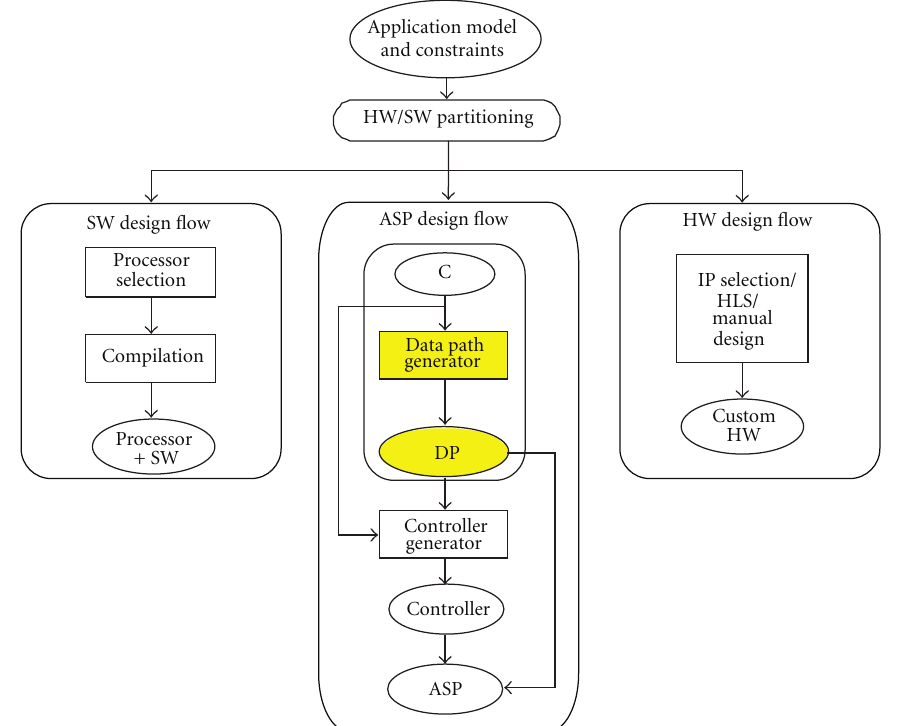
Figure 1: Proposed design technique within system-level design